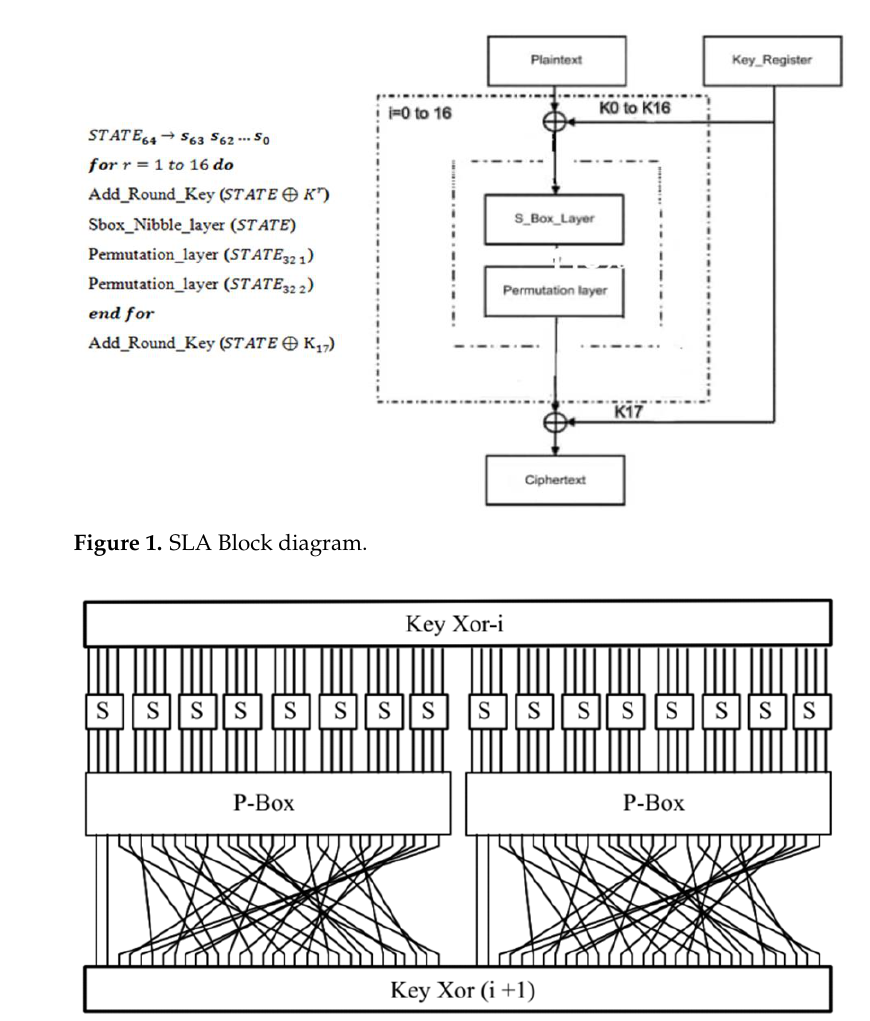
Figure 2. SLA Block cipher.